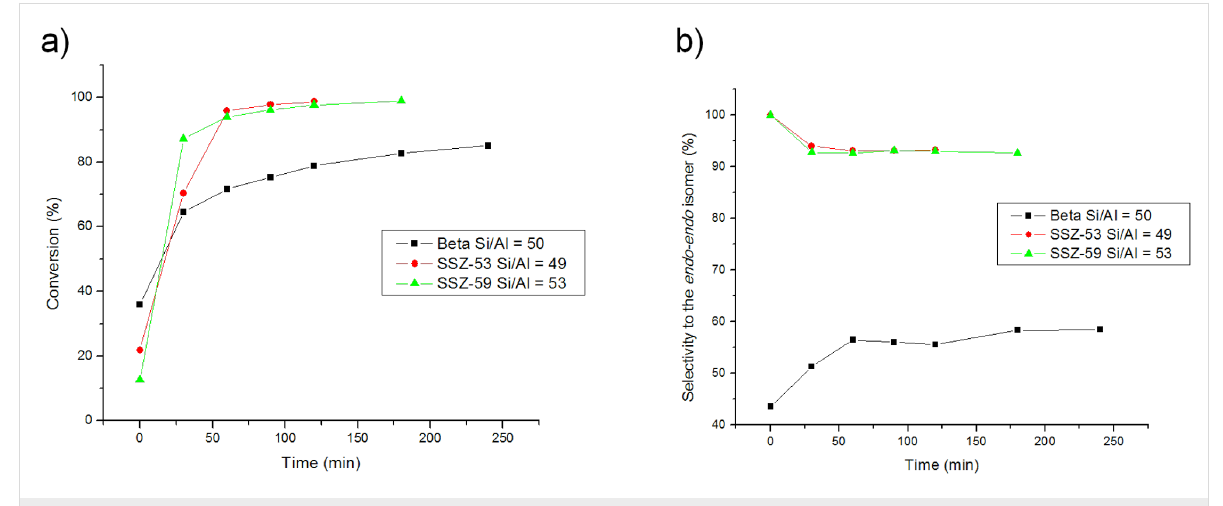
Figure 3: Effect of pore size in the conversion (a) and selectivity (b) of the DAR.